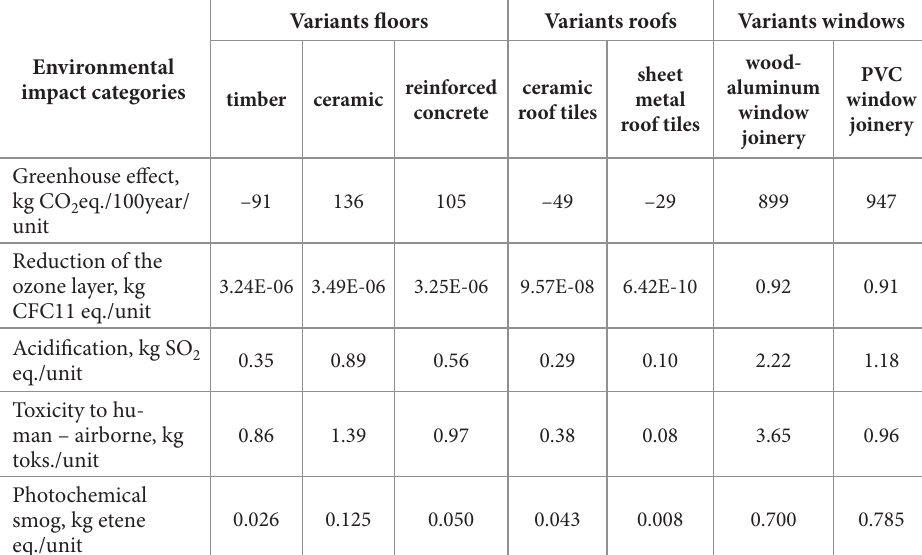
Environmental impact